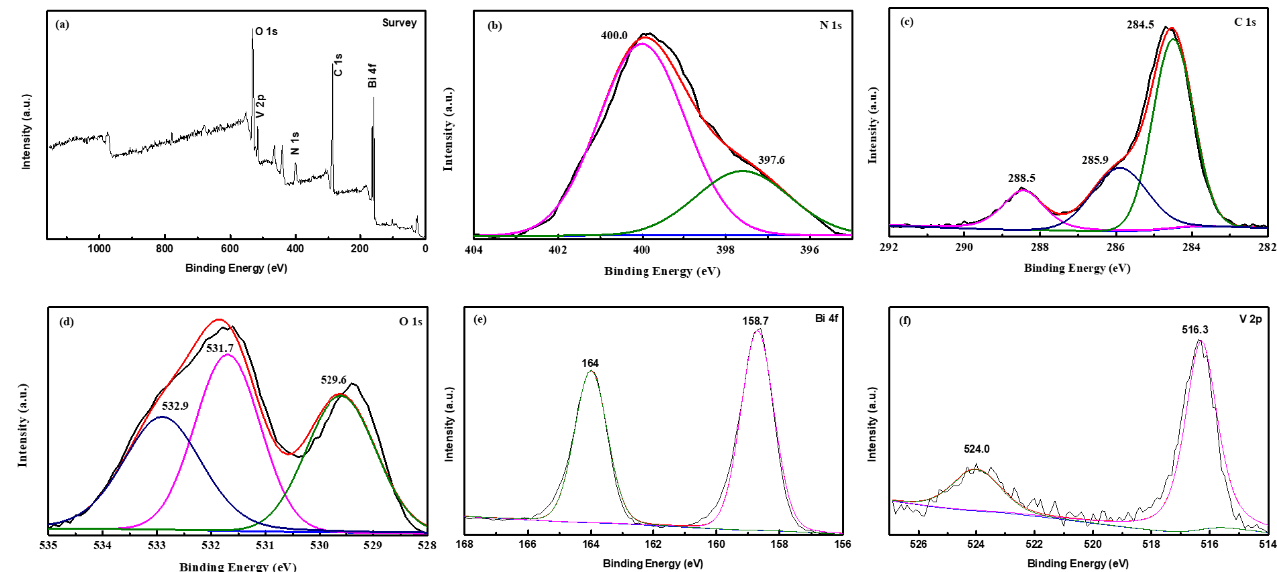
Figure 3. XPS spectra of 1.0-CN/BVO composite. ( a ) Survey spectra, ( b ) N 1s, ( c ) C 1s, ( d ) Bi 4f, ( e ) O 1s, ( f ) V 2p.